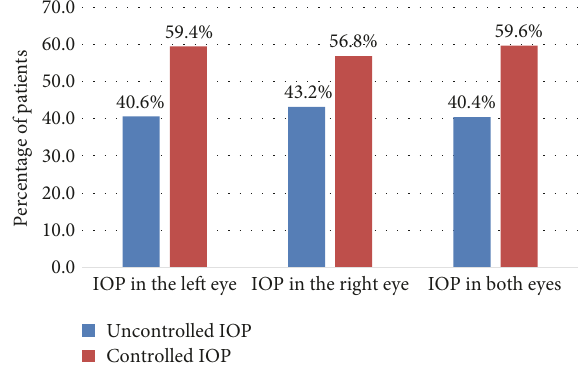
Figure 4: Comparison of the percentage of controlled intraocular pressure in the left, right, and both eyes among glaucoma patients in Menelik II Hospital,